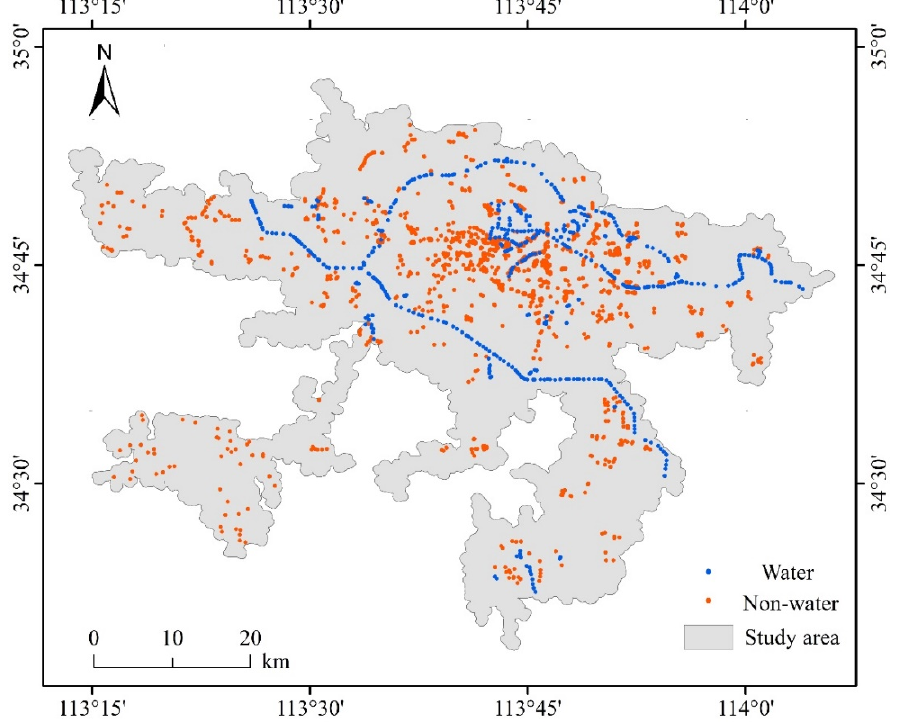
Figure 4. Spatial distributions of the randomly selected samples for accuracy verification of the annual maps of urban surface water bodies in Zhengzhou from 1990 to 2020.